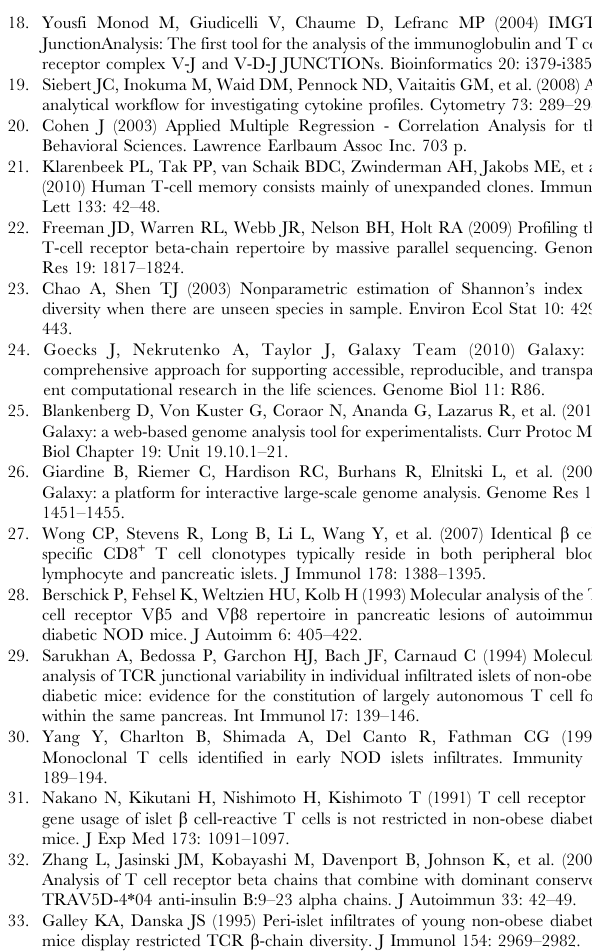
a), R2 (panel b), and R3 (panel c) indicate selection of lymphocytes and exclusion of doublets. Region R4 in panel d identifies CD4 + cells. Panel e shows the expression of CD44 on gated CD4 + T cells (R4). The marker in panel e shows the region used to sort memory CD4 + CD44 high cells, which were defined as CD4 + T cells expressing the highest level of CD44 (in this case 29.8% of CD4 + CD44 high cells). (TIF) Figure S2 Validation of the sequencing protocol. Se- quence copy counts of TCR b CDR3 regions obtained by sequencing the same cDNA sample from prediabetic mouse # 1 (A) and diabetic mouse # 14 (B) in two separate PCR reactions. Each point in the log–log scatter plot represents a unique clone. Points in green were found in both reactions and those in blue or yellow were found in one PCR reaction. (TIF) Figure S3 PCR bias assessment. Each V b primer was PCR amplified and sequenced against all J b primers. After processing, all TRBV gene sequences were mapped and recorded. The graph shows the combined data set for all TRBV genes. The bars correspond to the number of TRBV segments correctly assigned (white), the number miss-assigned to a particular TRBV gene (black) and the number of sequences incorrectly assigned from a particular TRBV gene (grey). (TIF)